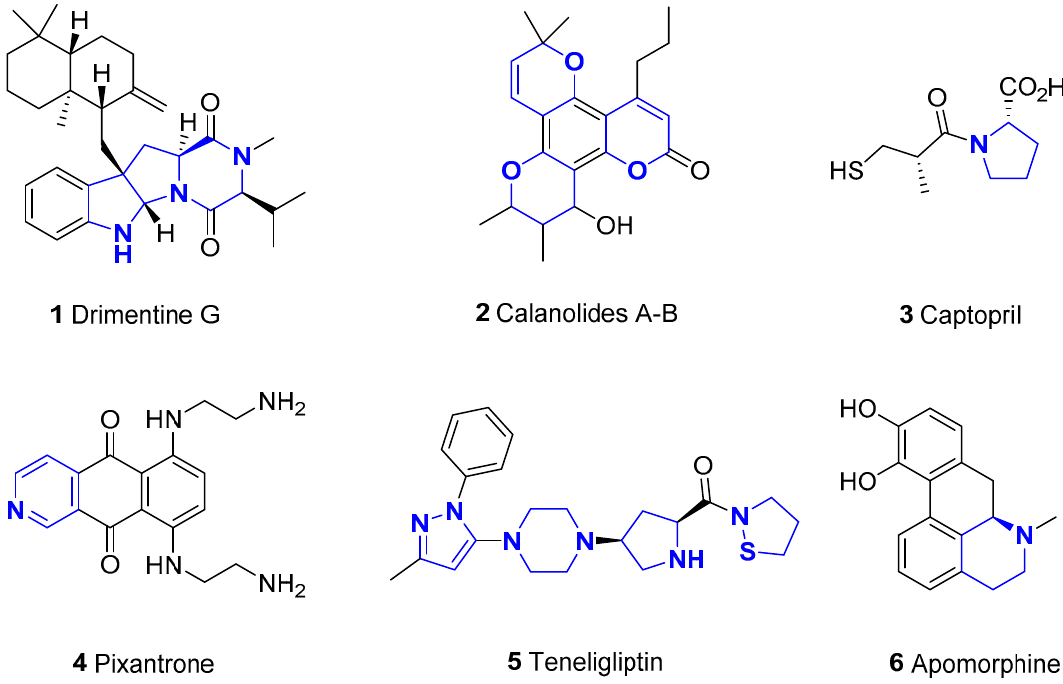
Figure 1. Selected example of current drugs containing heterocyclic scaffold.